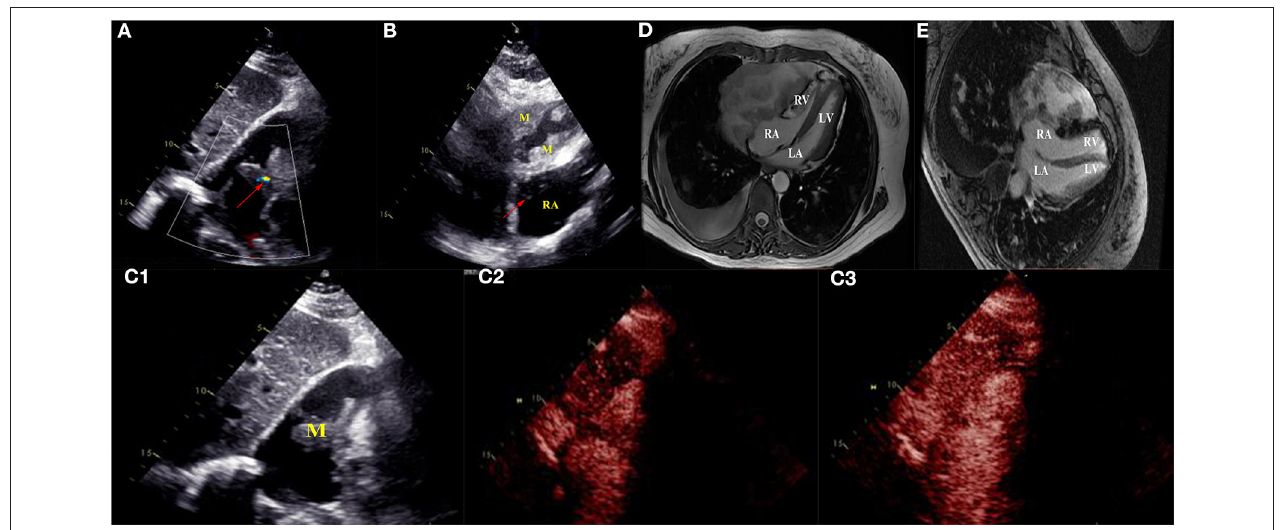
FIGURE 2 | Transthoracic echocardiogram revealed a huge mass in the pericardium surrounding and compressing the right atrium and right ventricle (A,B) . Mild blood flow signals (arrow) were seen in the mass (A) (May 20, 2020). The tumor was significantly larger than before and strip-like hyperechoism (arrow) inside the right atrium (B) (June 18, 2020). Contrast-enhanced ultrasound revealed the mass transferred right atrium, and the mass was rapidly filled with contrast agent (C1–C3) (May 20, 2020). Axial Fiesta (D) and 4CH-2D (E) images of cardiac magnetic resonance showed an irregular, large tumor (size up to 10 × 5.5cm) with heterogeneous distinction diffusely within the pericardium (10 × 5.5cm), mainly locating outside of right cardiac system, and compressed the right heart. RA, right atrium; RV, right ventricle; LA, left atrium; LV, left ventricle; M, mass; RA, right